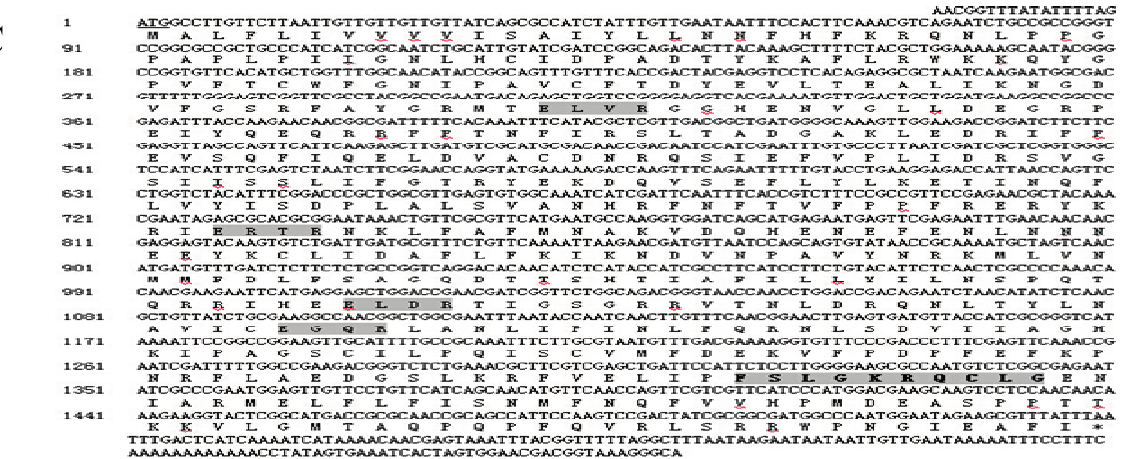
Figure 1. Full-length cDNA sequences and deduced amino acid sequences of BxCYP33C9 ( A ), BxCYP33C4 ( B ) and BxCYP33D3 ( C ) from B. xylophilus. Note: The initiation codon